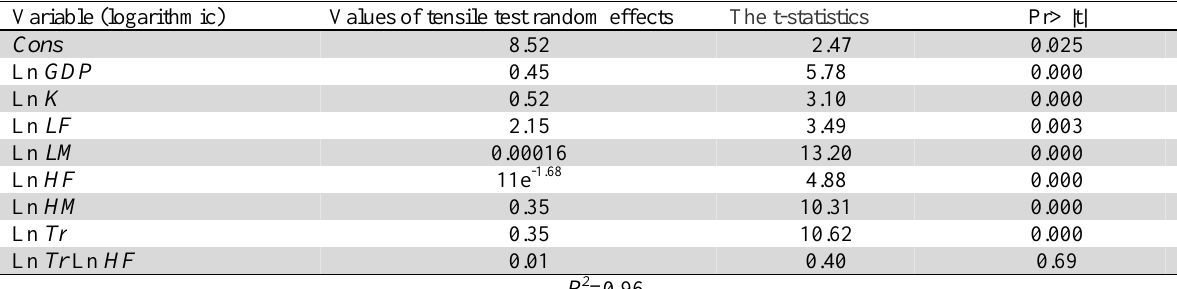
The results of estimating Eq. (13) for